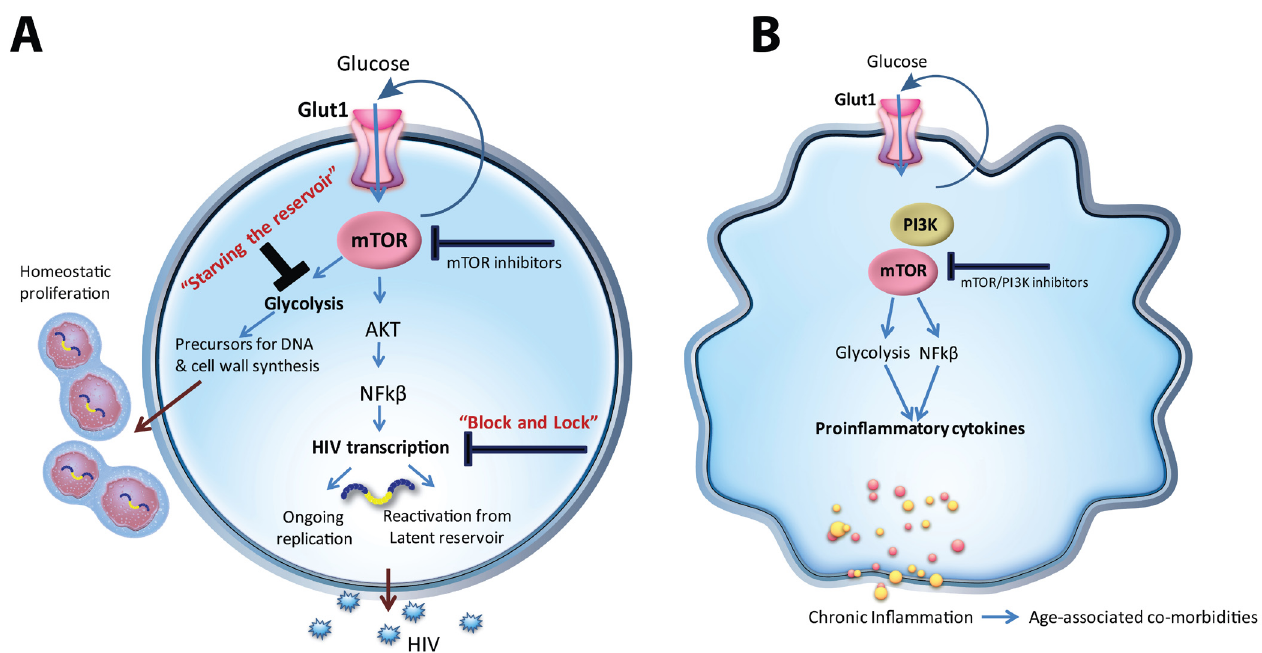
Figure 1. CD4 + T cells reprogram glucose metabolism during infection from oxidative phosphorylation (OXphos) toward glycolysis marked by increased cell surface Glut1 and mTOR activation. ( a ) mTOR regulates HIV transcription critical for viral reactivation and ongoing replication. Glycolysis regulated by mTOR provides precursors for DNA and cell wall synthesis which support homeostatic proliferation of infected CD4 + T cells. ( b ) Similar to CD4 + T cells, mTOR/PI3Kinase regulates monocyte/macrophage Glut1 cell surface expression and metabolism. A metabolic shift toward glycolysis supports pro-inflammatory cytokine production in monocytes/macrophages. Glut1, glucose transporter 1; mTOR, mechanistic target of